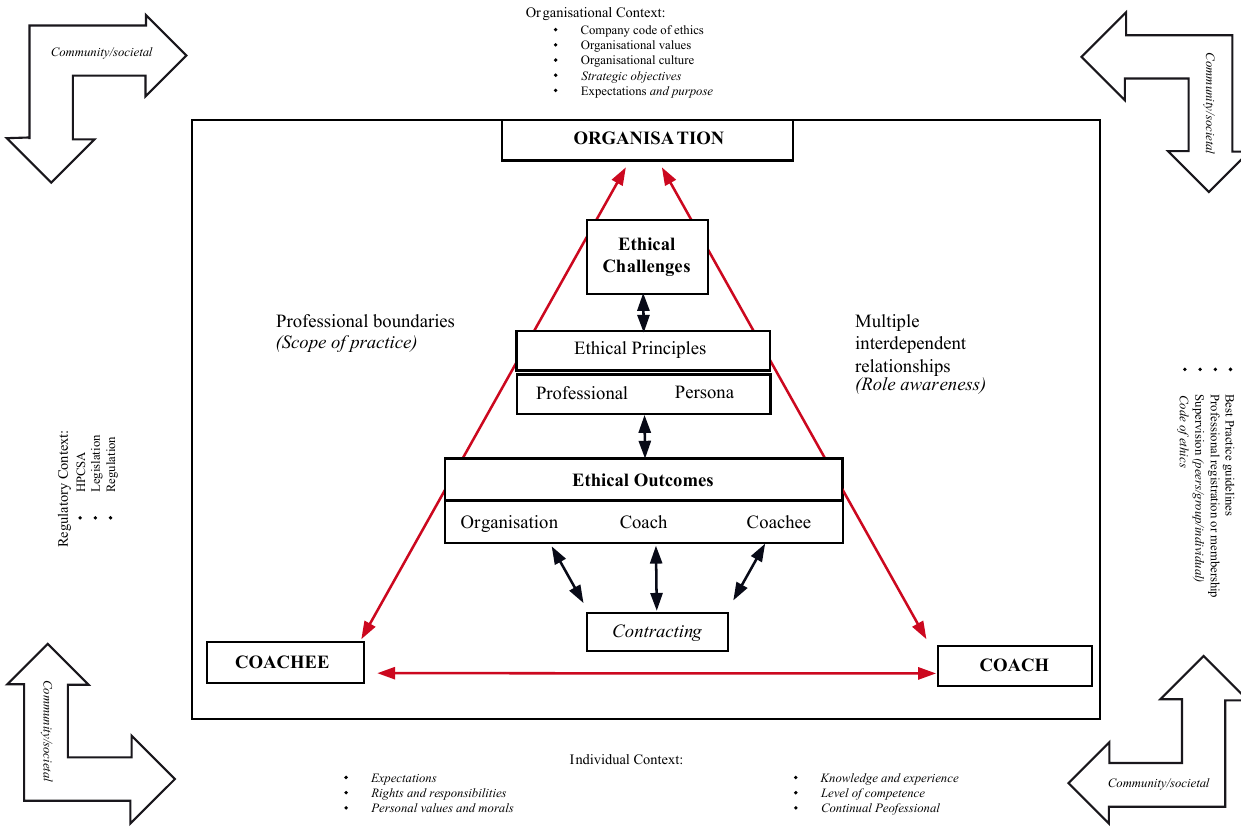
FIGURE 1: Outputs of the first and second round of the Delphi technique: Adapted Exploratory Framework of Ethical Challenges informed by coaching